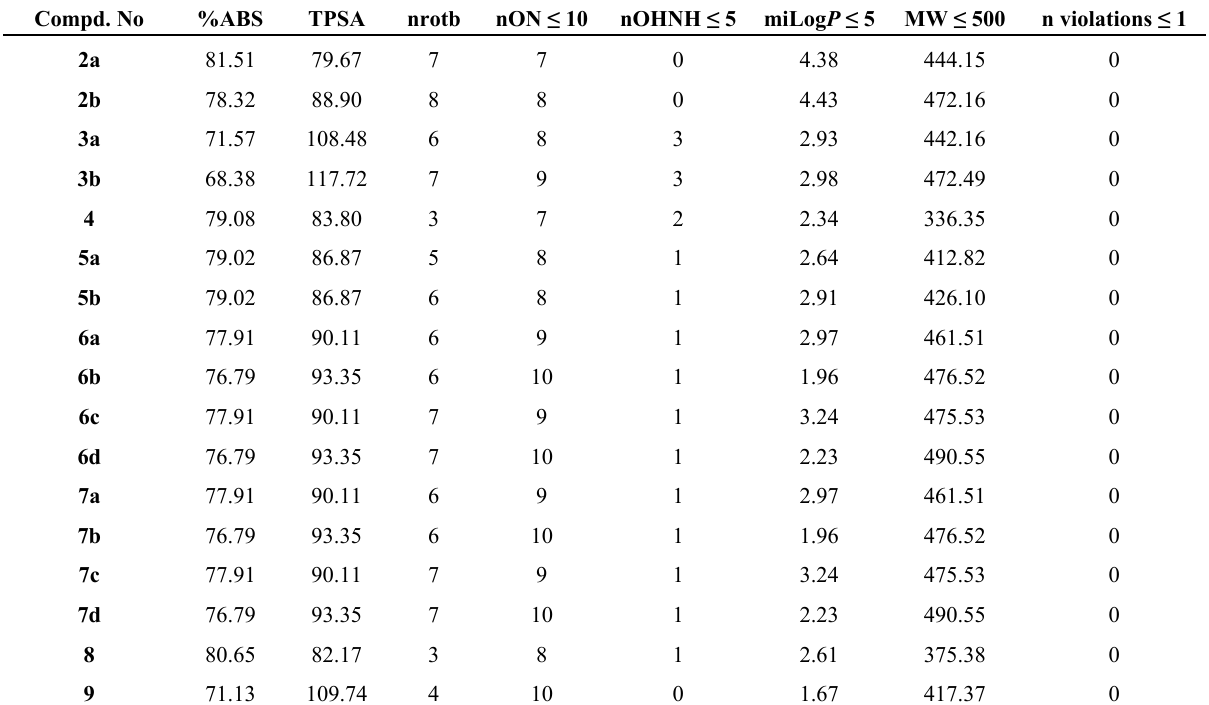
Table 2. Calculated absorption (%ABS), polar surface area (PSA) and Lipinski parameters of the newly synthesized